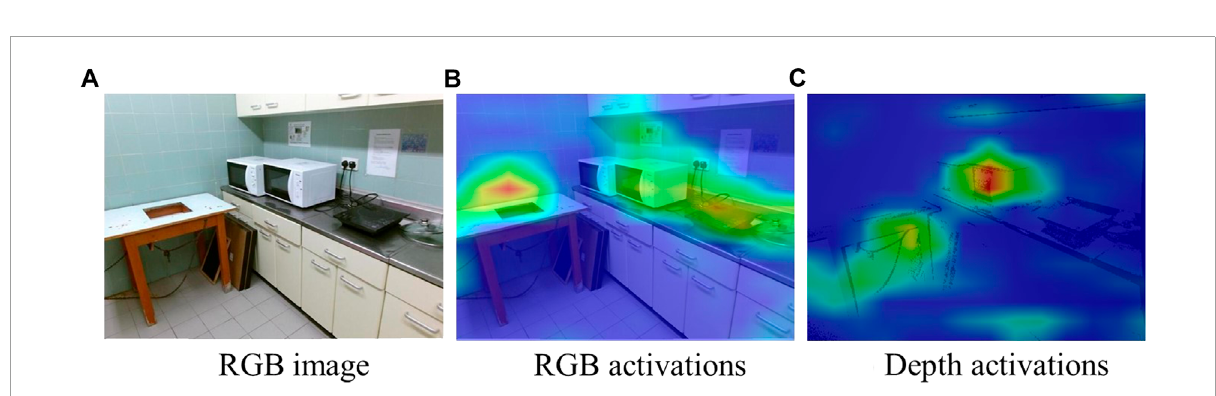
FIGURE 6 The RGB image (in (A) ), the heatmap activations of RGB image (in (B) ), and depth activations (in (C) ) when the expression is “the microwave closer to the table.”